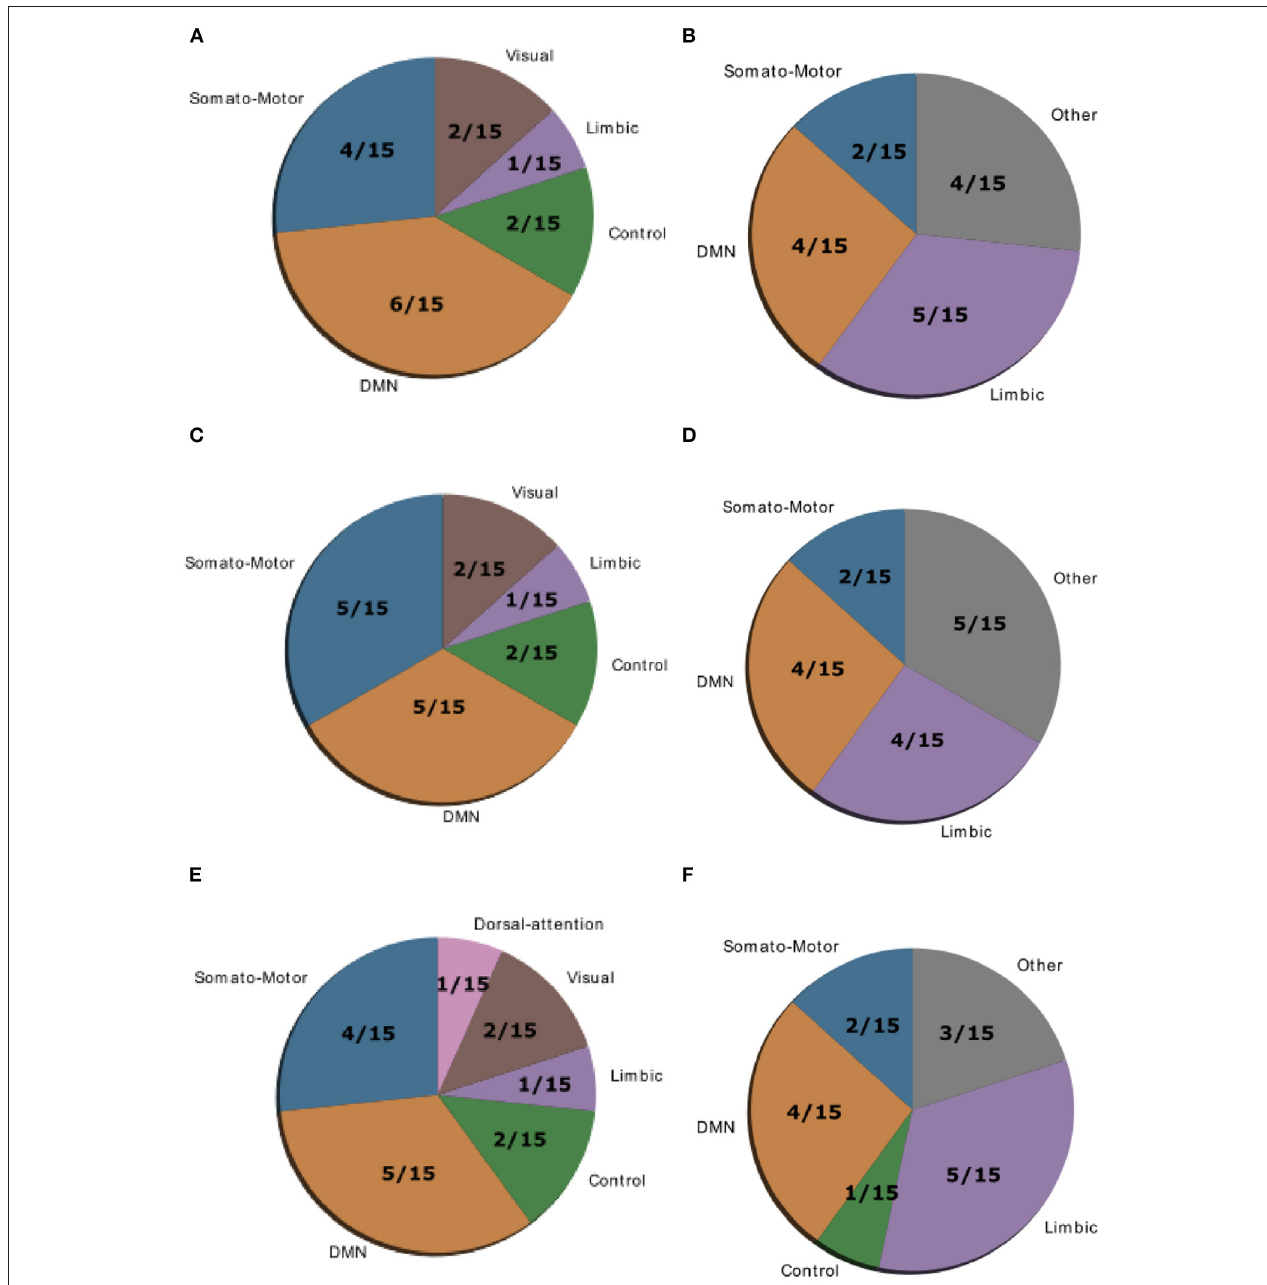
FIGURE 4 | Location of cognitive control hubs for controllability across large-scale cognitive systems in the HC group [average controllability (A) and modal controllability (B) ], the SCZ group [average controllability (C) and modal controllability (D) ] and the SCZaff group [average controllability (E) and modal controllability (F) ]. We chose the top 15 regions with highest average and modal controllability (averaged over all subjects),